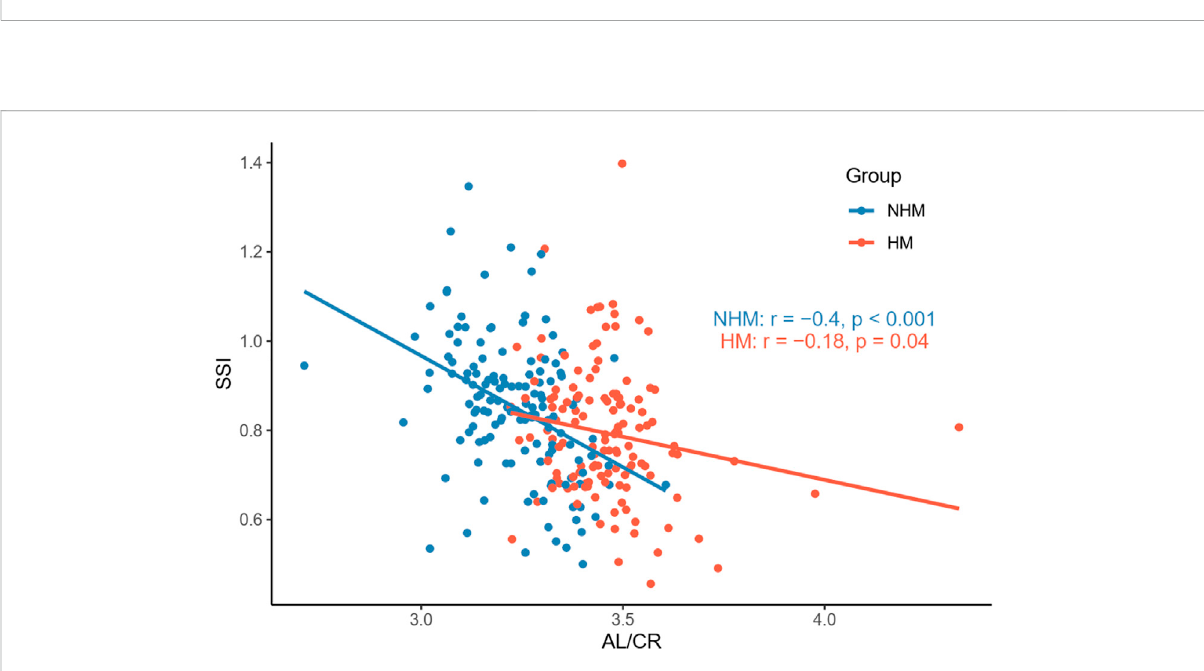
FIGURE 6 Relationship between AL/CR and SSI in the two groups. AL/CR was signi fi cantly associated with SSI in both the NHM and HM groups. Abbreviation: NHM, non-high myopia; HM, high myopia; SSI, stress – strain index; AL/CR: axial length/corneal radius of curvature